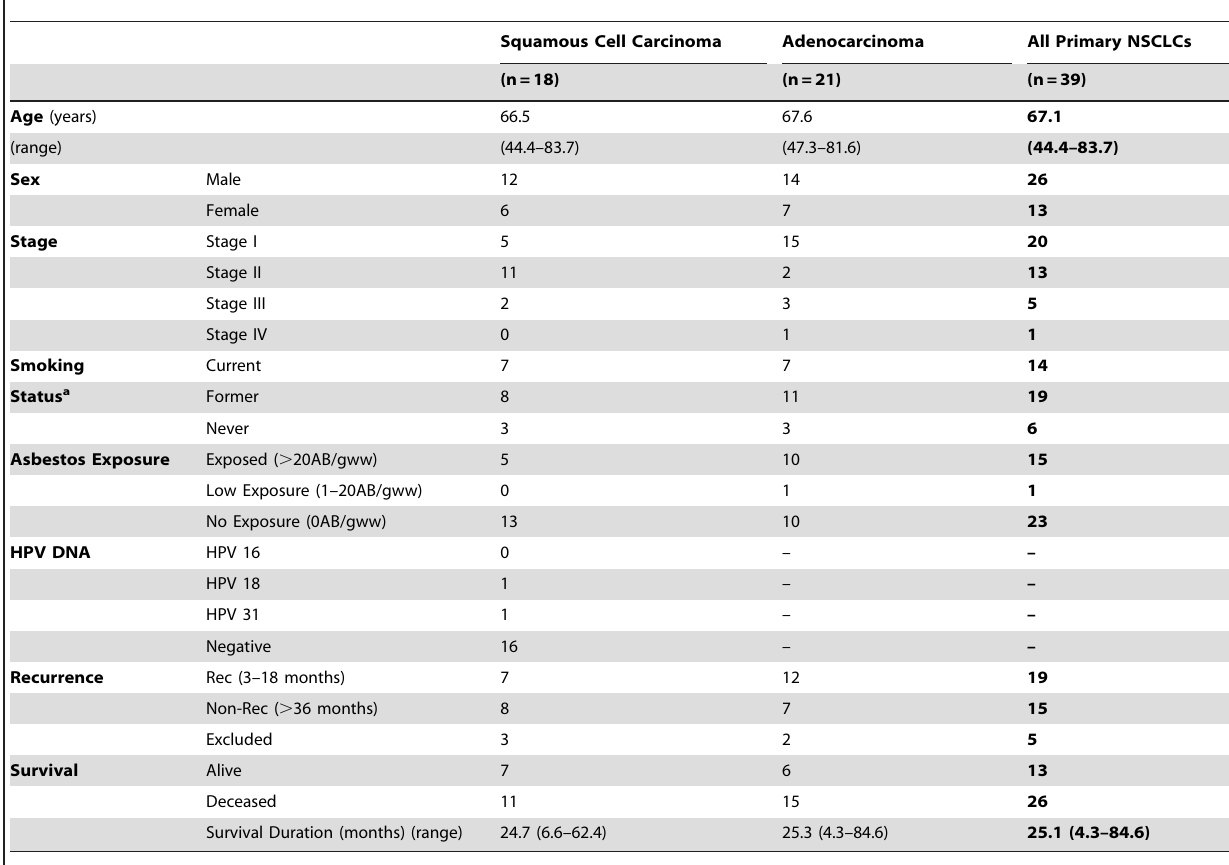
Table 2. Clinicopathological characteristics of miR-218 validation